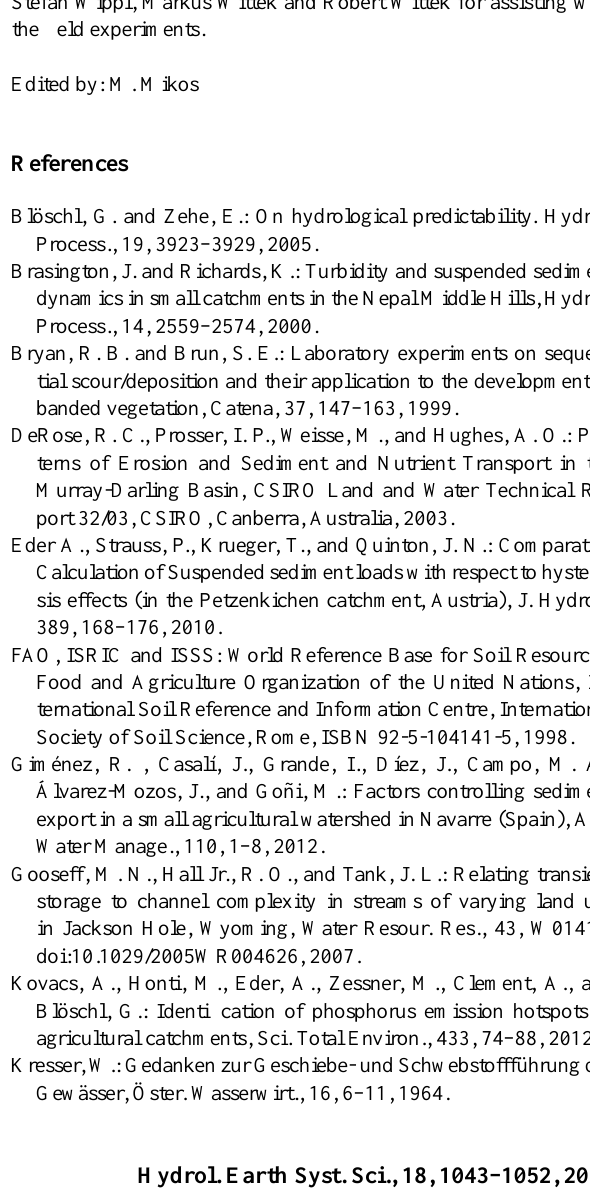
Stefan Wippl, Markus Wittek and Robert Wittek for assisting with the field